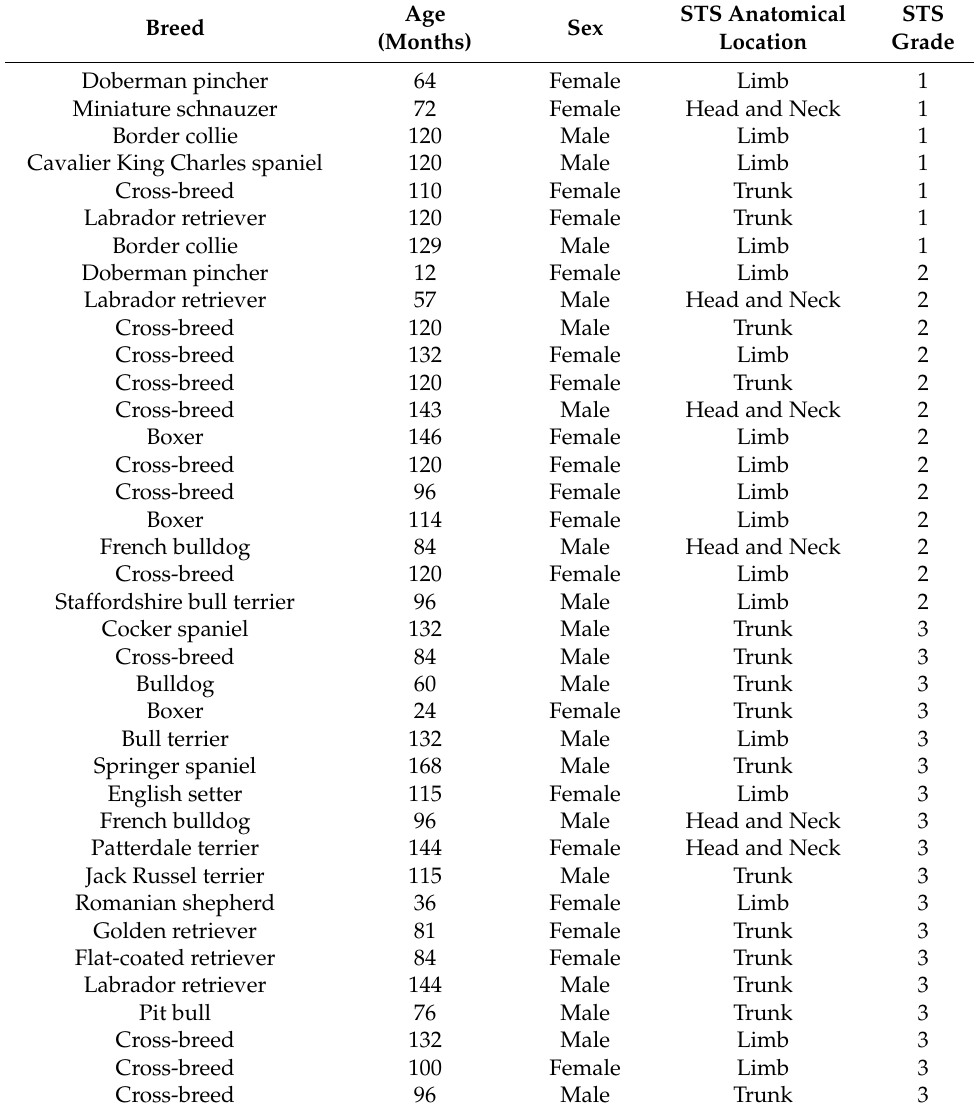
Table 1. Characteristics of the study population. Signalment, anatomic STS location, and histo- logic